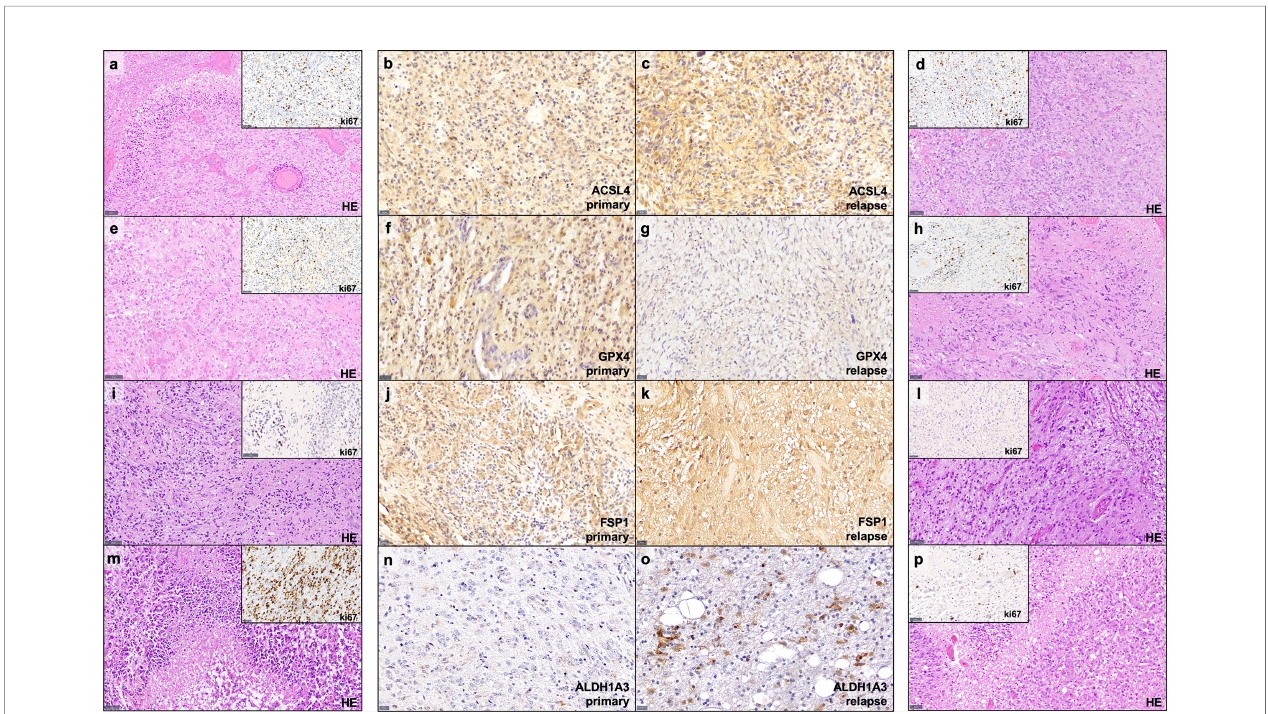
FIGURE 1 | Examples of immunohistochemistry staining. Shown are paired GBM primary and relapse with stronger ACSL4 and ALDH1A3 expression in the relapse (C, O) compared to the primary tumor (B, N) . In contrast, GPX4 and FSP1 display a stronger expression in the primary tumor (F, J) compared to their relapse (G, K) . Furthermore, for each example of primary and recurrent GBM, a hematoxylin and eosin (HE) stains as well as a ki67 immunohistochemistry of representative areas are provided (A, D, E, H, I, L, M, P) . Scale bars of ACSL4, GPX4, FSP and ALDH1A3 immunohistochemistry: all 20 m m; Scale bars of HE and ki67 immunohistochemistry: all 50 m